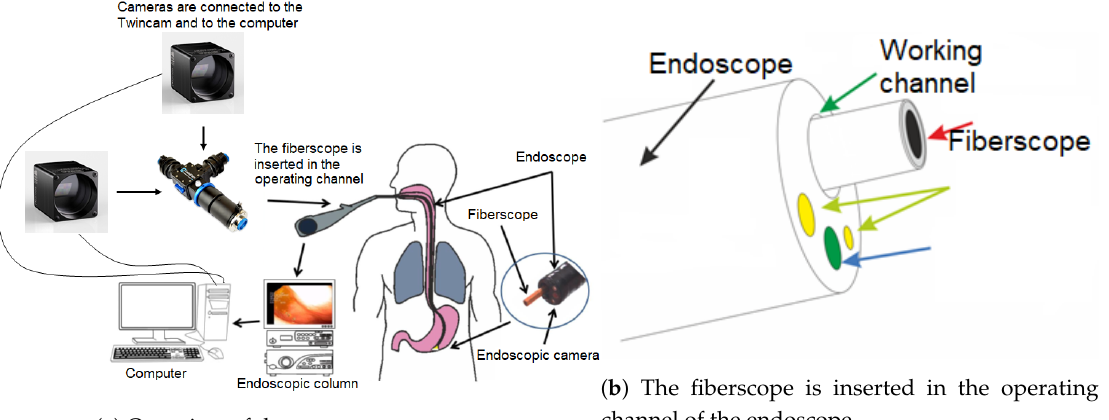
Figure 2. Functional scheme of the